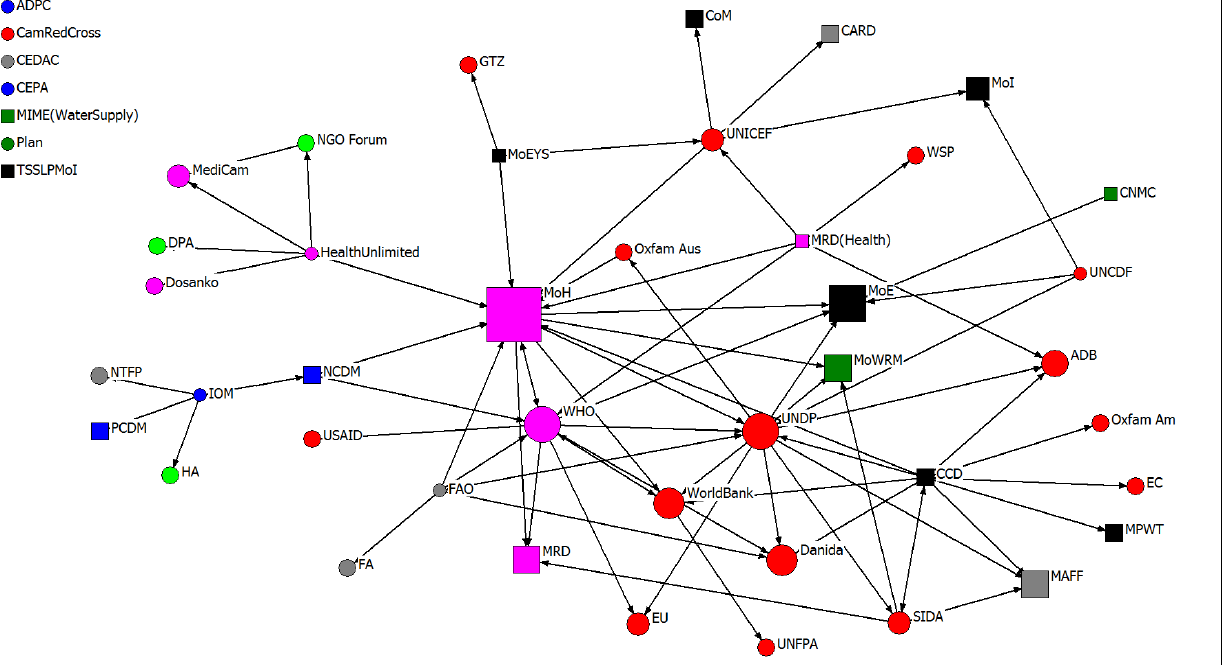
Figure 1. Health and climate change partnerships in